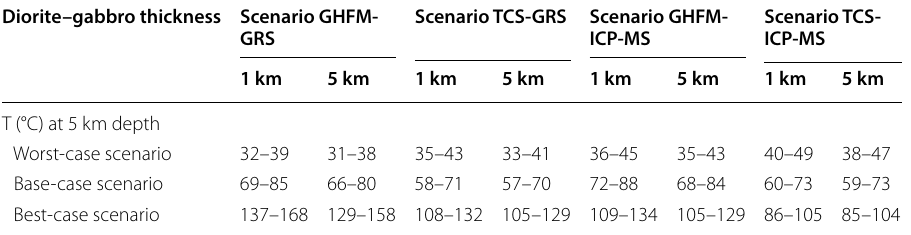
Table 6 Temperature at depth scenarios based on the thermal properties of the geological materials Diorite–gabbro thickness Scenario GHFM-